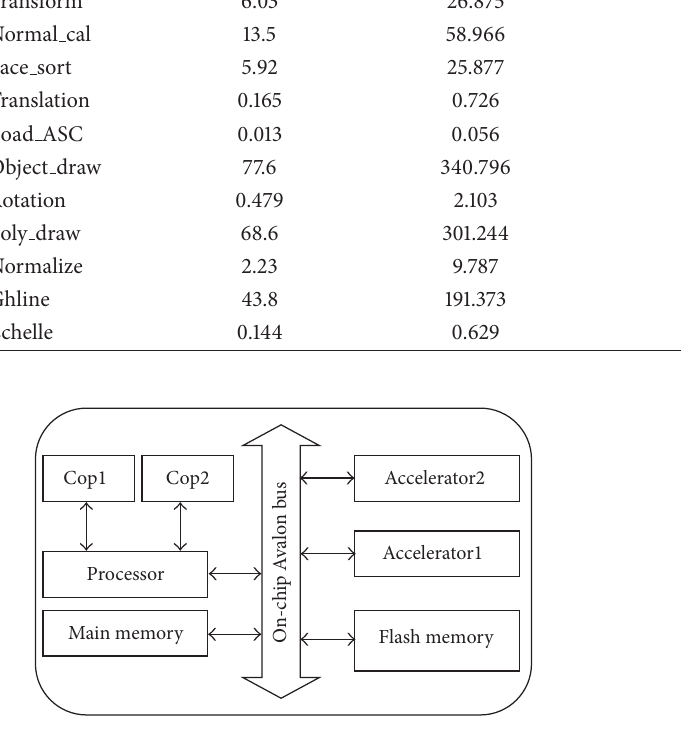
Figure 8: Hardware architecture.